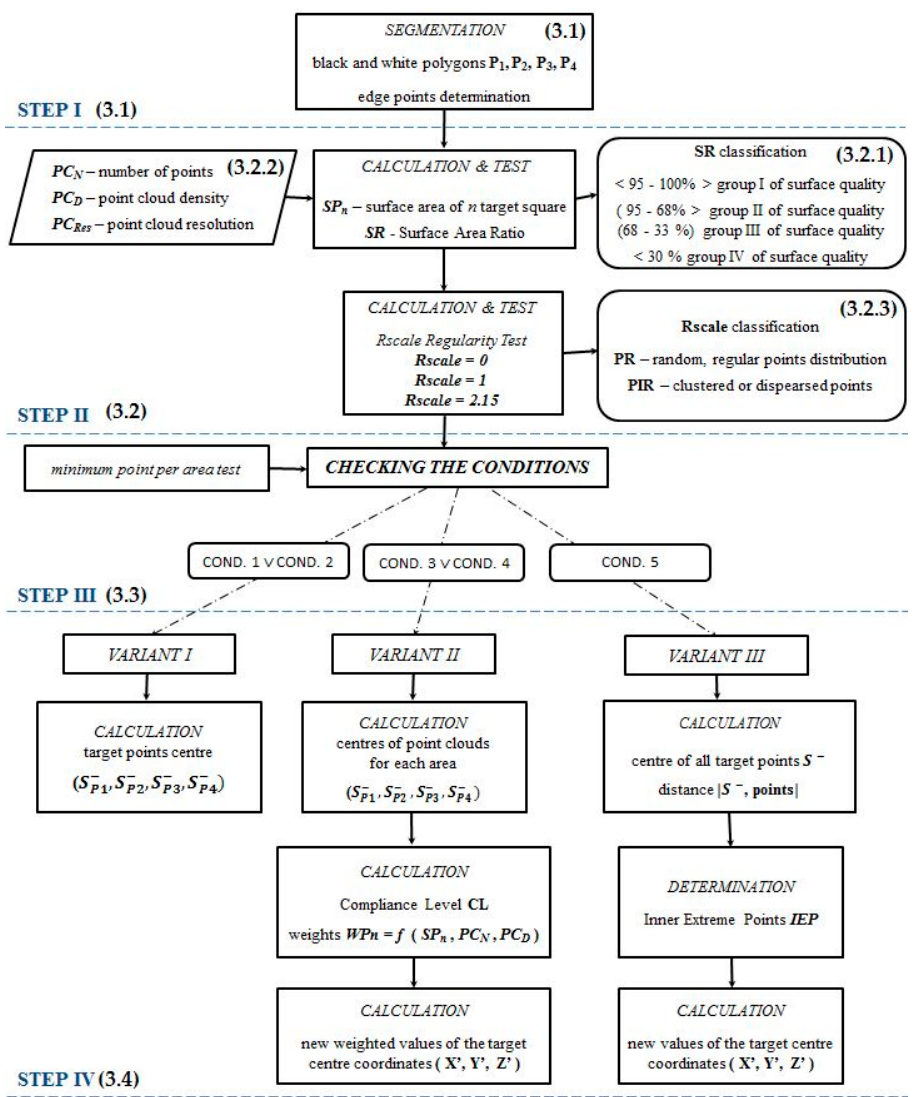
Figure 6. Overview of the methods for the developed approach. Numbers in brackets represent the corresponding sections in this paper.